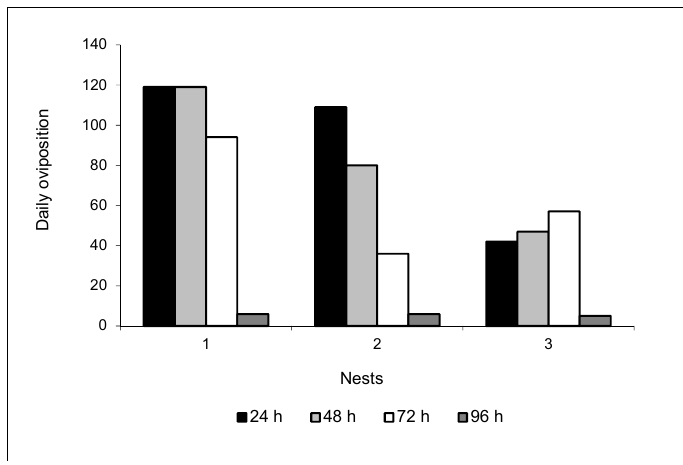
Figure 1. Daily oviposition of queens from three nests of Acromyrmex rugosus rugosus . Temperature: 24 °C.